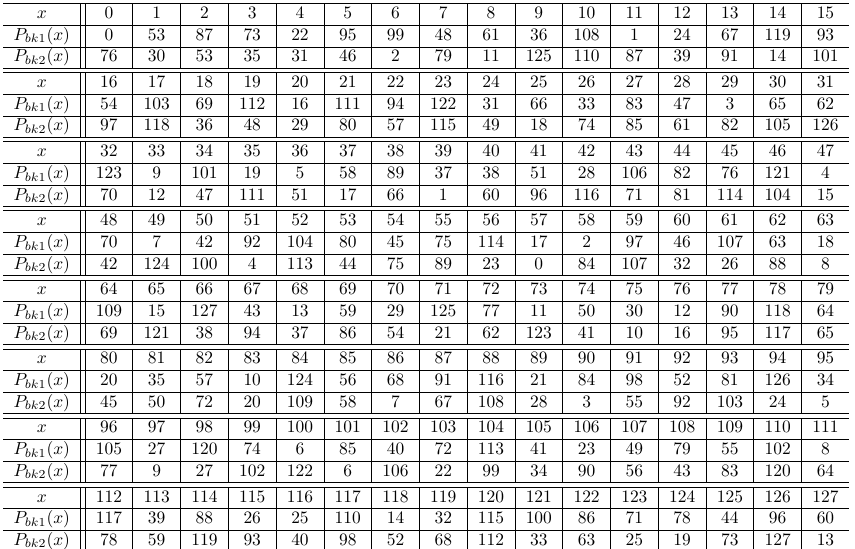
Table 2: Bit permutation P bkN for key scheduling KSF N , where N ∈ { 1 , 2 } .